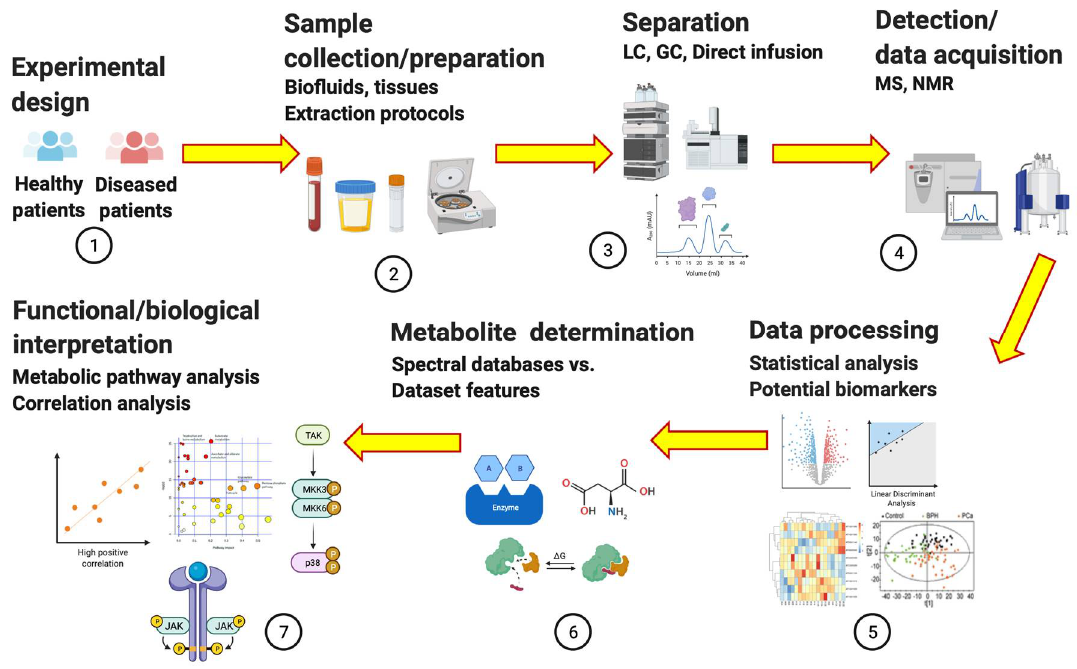
Figure 1. Process flow for untargeted and targeted metabolomics as applied to disease biomarker research. Figure drawn using BioRender [26].